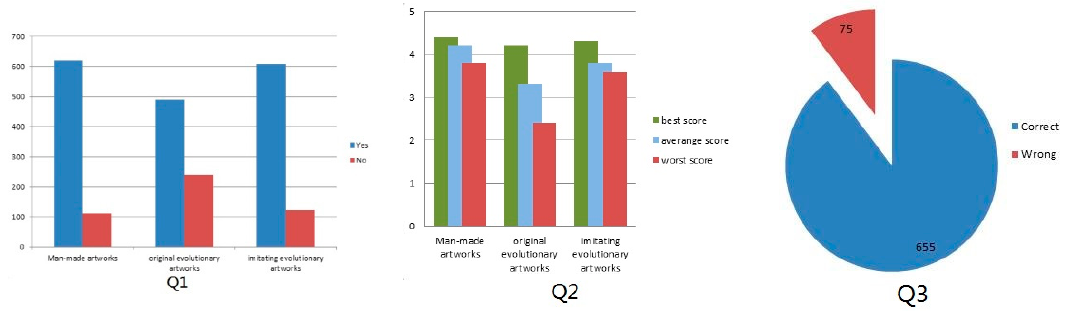
Figure 5. Questionnaire results of proposed art.